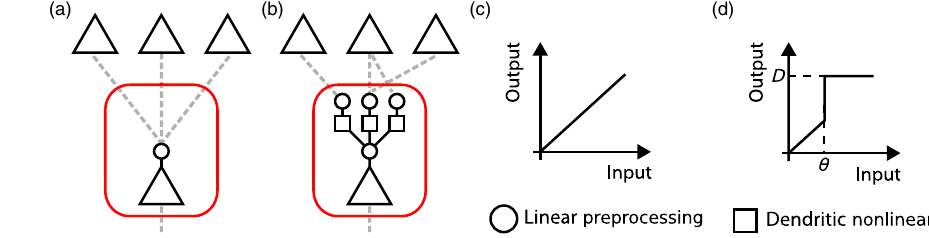
FIG. 1. Arborized neuron with dendritic nonlinearities. Network architecture for (a) a classical point-neuron model without dendrites and (b) an arborized neuron with B ¼ 3 dendrites (or dendritic branches) modeled as separate compartments. The red boxes mark the neuronal unit for each case. (c) Circles represent linear summation of inputs; triangles and squares represent somatic and dendritic processing, respectively. In a point neuron, all inputs are summed up linearly and then processed nonlinearly. In a model with nonlinear dendrites, there is an additional, preceding layer where inputs to each dendrite are summed up linearly and then subjected to a dendritic nonlinearity. (d) This nonlinearity is modeled as a piecewise linear function with threshold θ and saturation strength D , incorporating the effect of dendritic spikes. The somatic transfer function is not constrained in the